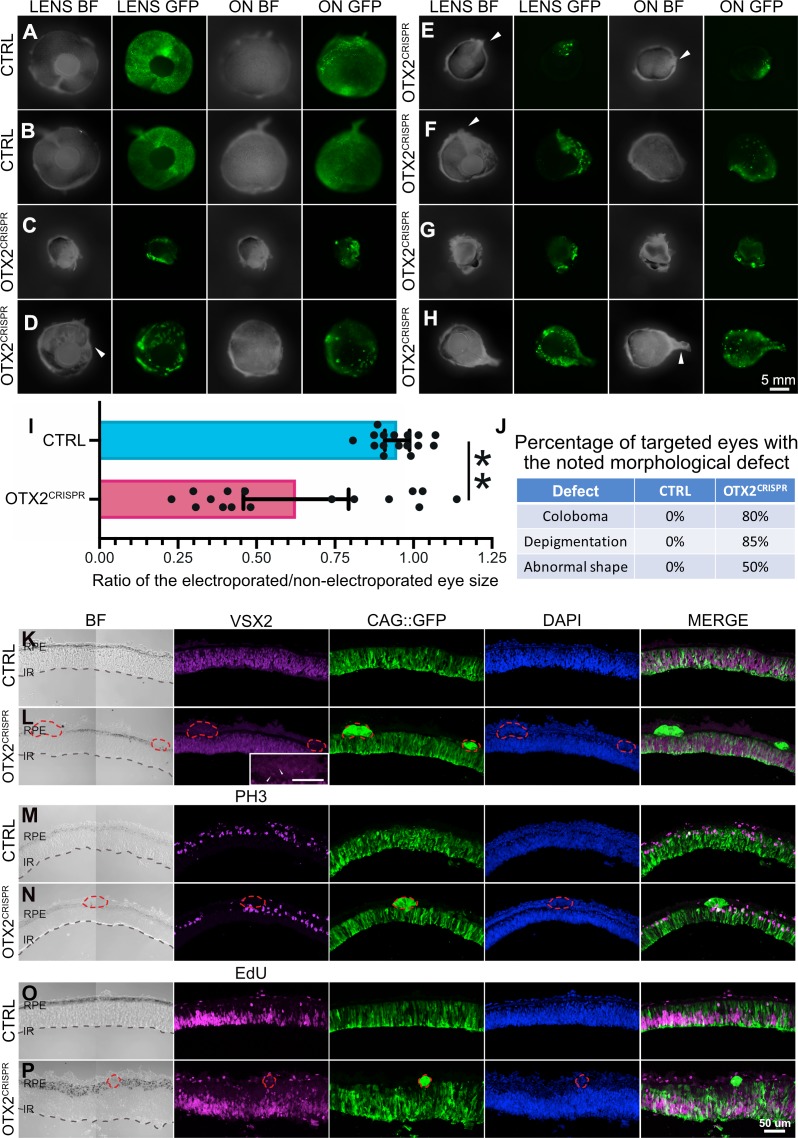
Effects of OTX2CRISPR mutation induced at the optic vesicle stage.(A–H) Phenotypes observed after eye cups were electroporated with OTX2CRISPR g2 complex and CAG::GFP at E1.5/HH 10 and analyzed at E5/HH 26. Images were acquired from the frontal (LENS) and dorsal (ON) view of whole eyes. GFP signal shows electroporation efficiency of the CAG::GFP control plasmid. Control (CTRL) eyes in (A and B) were electroporated with an empty p18 plasmid and CAG::GFP. All mutants (C–H) display different degrees of microphthalmia, RPE depigmentation, while some show coloboma-like defects and abnormal shape of the eye (C, E, F). Arrowheads point to the incomplete closure of the optic stalk giving the coloboma appearance and abnormal shape. (I) Microphthalmia was measured as the ratio between the area of the electroporated eye and the non-electroporated one. Error bars are 95% confidence intervals. (J) Quantification of the morphological defects.( I, J) n = 16, ** signifies p<0.001. (K–N) Vertical sections of CTRL and mutant retinas imaged by confocal microscopy for GFP, DAPI and either VSX2 expression (K,L), PH3 (M,N) expression, or EdU (O,P). BF, brightfield, ON, optic nerve, RPE, retinal pigment epithelium, IR, inner retina.